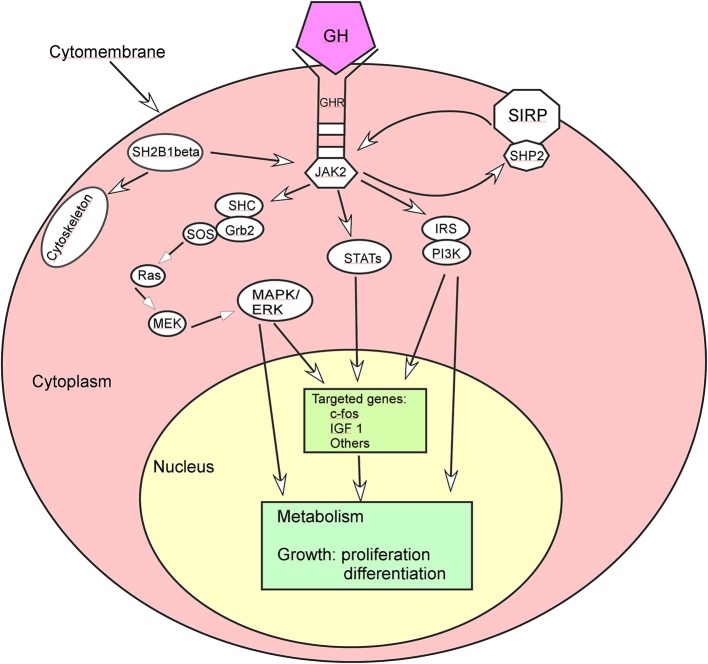
Growth hormone (GH) acts through some signal pathways. ERK, extracellular signal-regulated kinase; GHR, growth hormone receptor; Grb, growth factor receptor-bound protein; IRS, insulin receptor substrate; IGF 1, insulin-like growth factor 1; JAK2, Janus kinase 2; MAPK, mitogen-activated protein kinase; MEK, dual specificity mitogen-activated protein kinase 2; PI3K, phosphatidyl inositol 3 kinase; SHC, SH2-domain containing transforming protein; SIRP, signal regulatory protein; SOS, son of sevenless; STAT, signal transducer and activator of transcription.